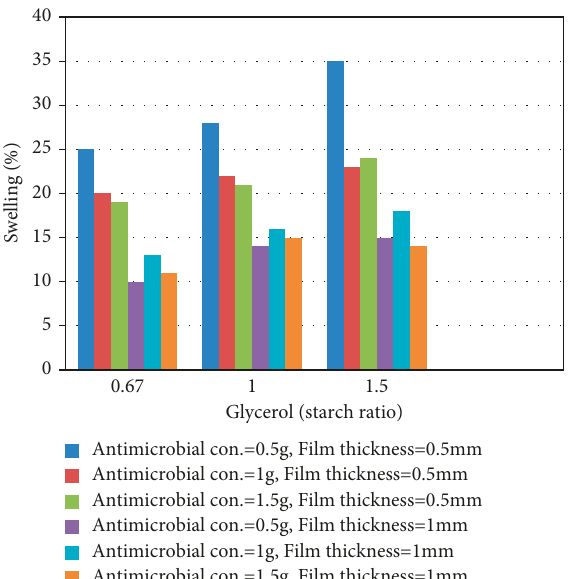
Figure 6: Swelling capacity of packaging films at different glycerol/ starch ratios.